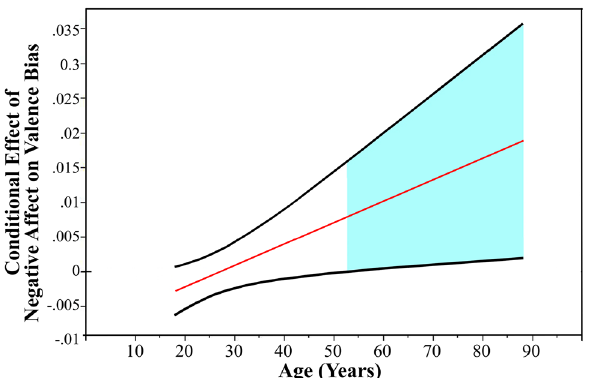
Figure 3. Depiction of the significant interaction between negative affect and age. The straight line represents conditional effects of negative affect on valence bias at different ages and the curved lines reflect the 95% confidence interval for those effects. Negative affect was positively associated with a more negative valence bias, controlling for social connectedness, for individuals age 51.6 and older (i.e., beginning at 1.95 SDs above the mean of